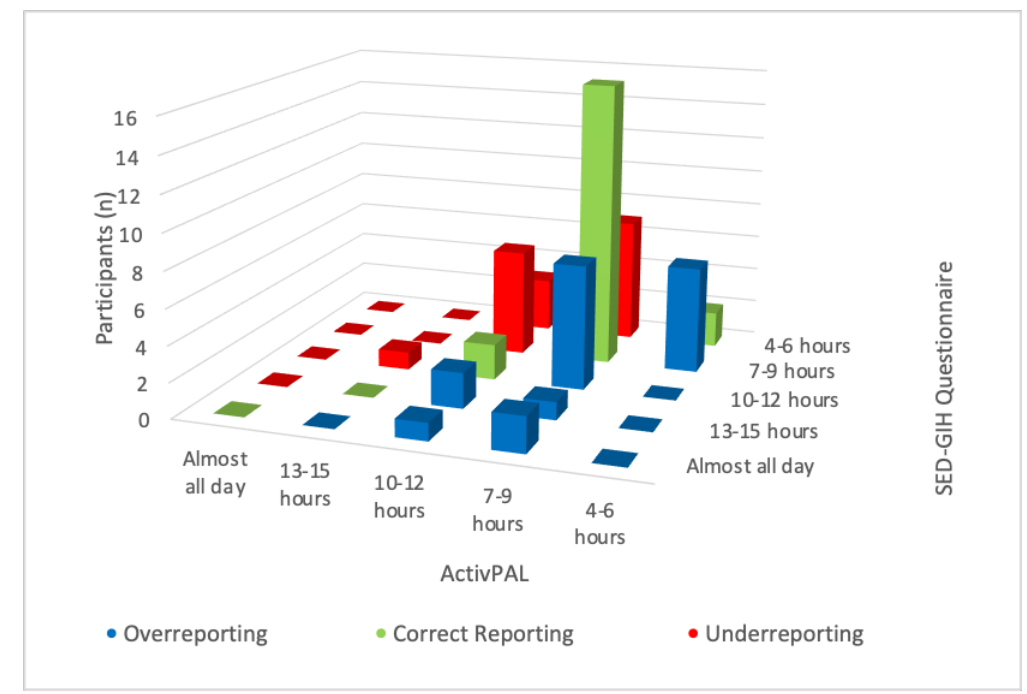
Figure 3. Frequency of over-reporting, correct reporting, and under-reporting in the different response categories for SED-GIH compared with ActivPAL.